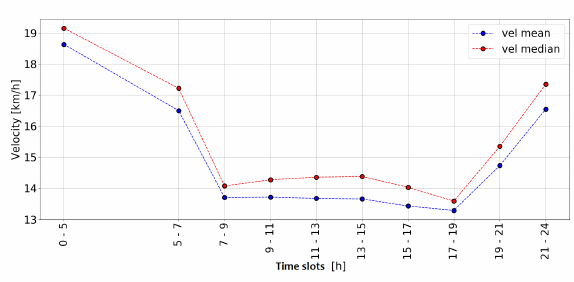
Figure 10. Line 11: time slot velocities in working days.